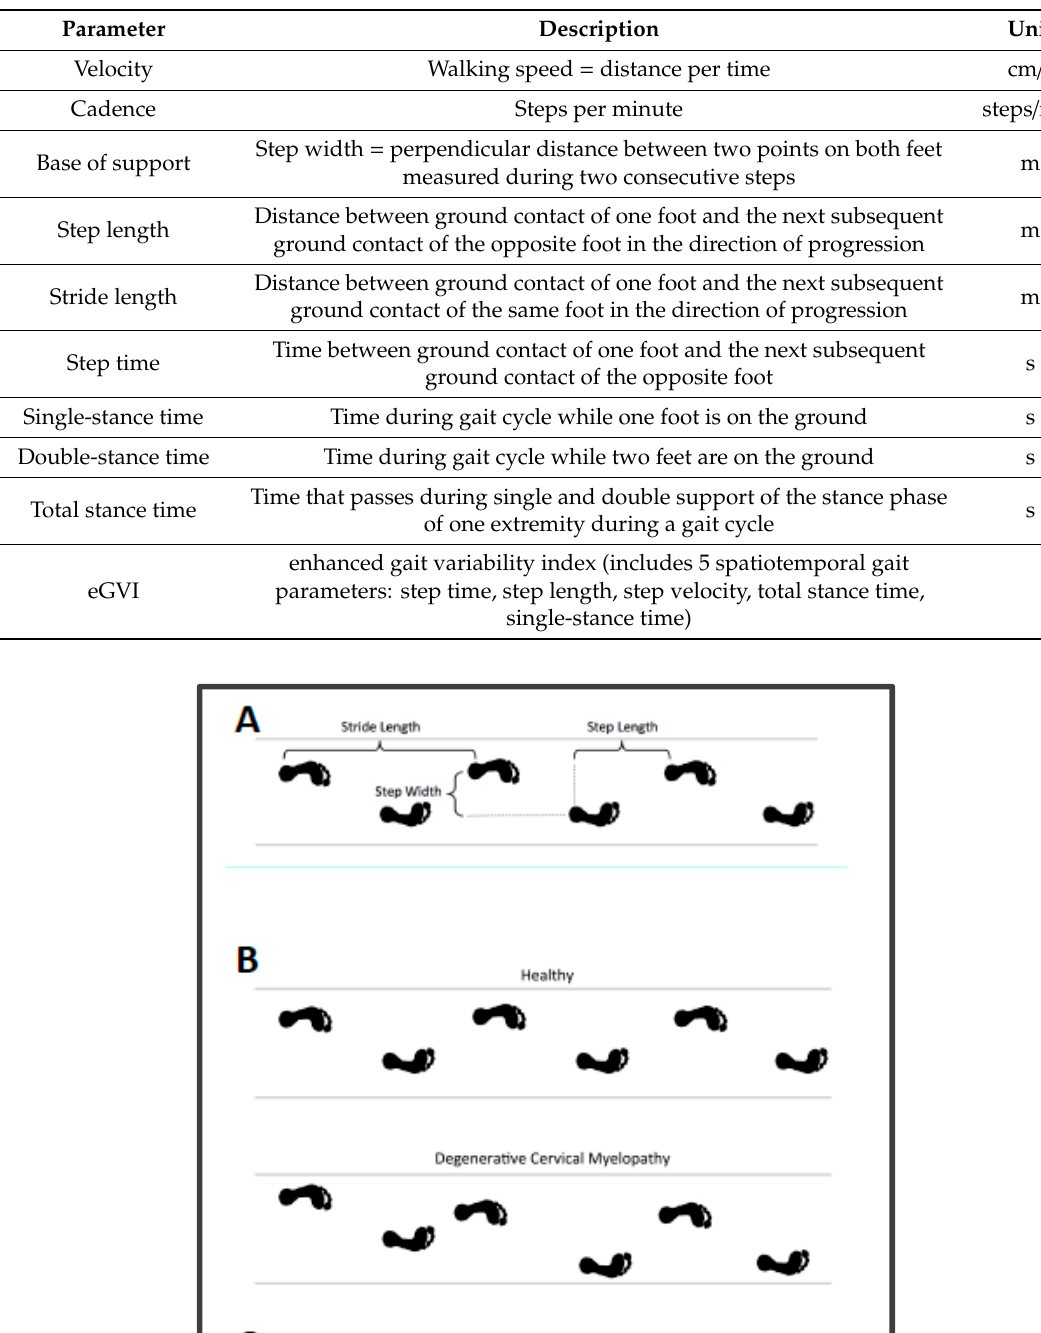
Table 2. Spatiotemporal gait parameters.